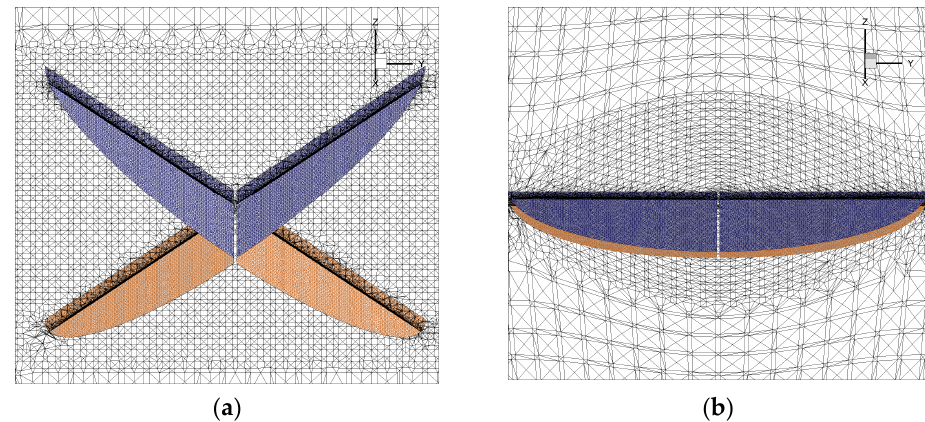
Figure 7. Computational grids. ( a ) Initial computational grid. ( b ) Automatically remeshing computational grid.